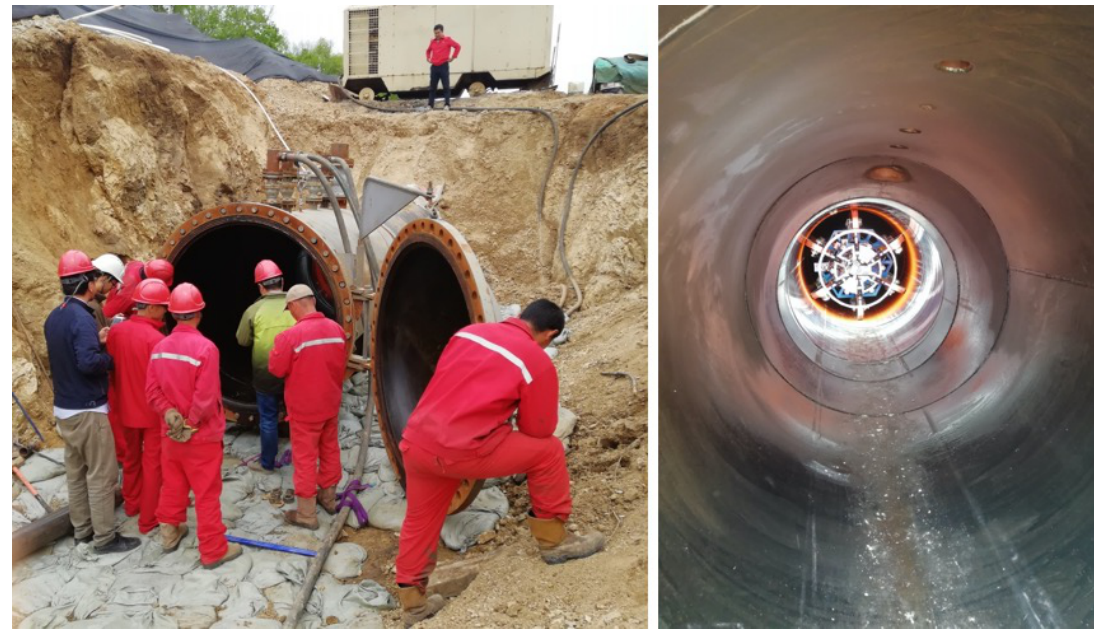
Figure 13. Robot deployment and